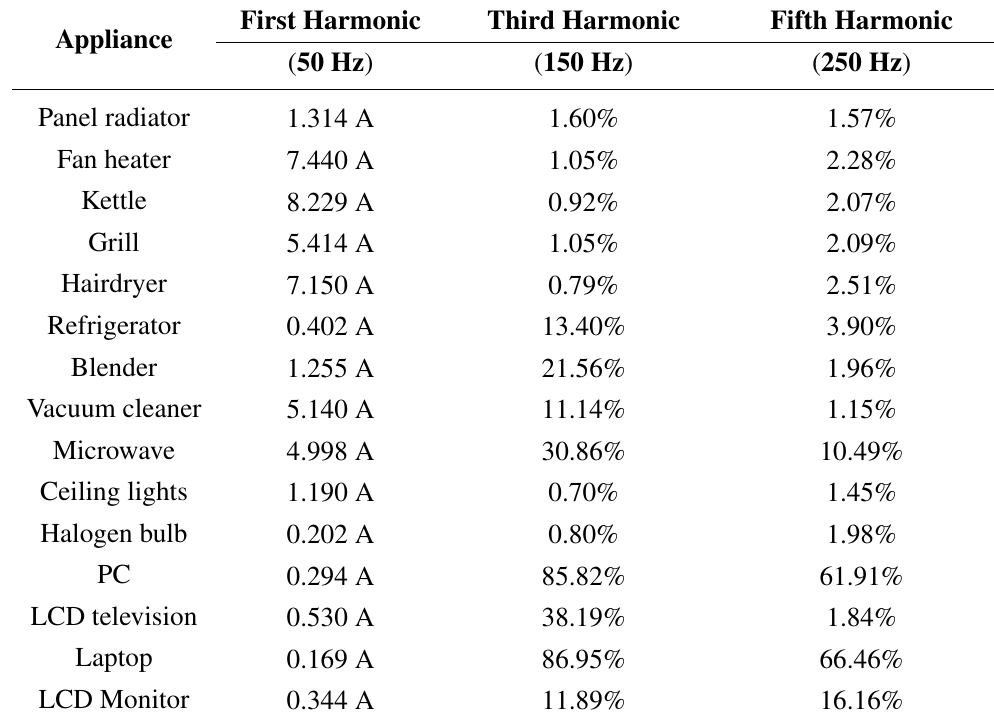
Table 4. The mean of the amplitude of the current harmonics for each appliance used in this